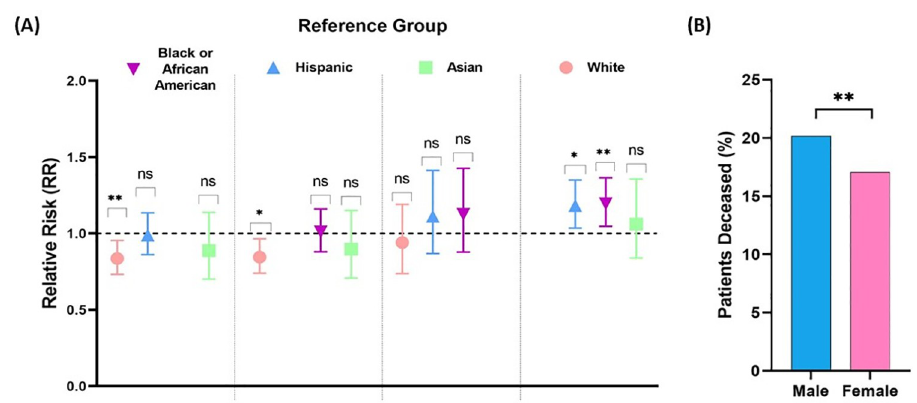
Fig 3. COVID-19 mortality in Mount Sinai Health Systems stratified by race and ethnicity and by sex. (A) Relative risk of mortality from COVID-19 stratified by race and ethnicity. Whites have a higher relative risk of mortality from CoV2 infection relative to the Black or African American and Hispanic population. There was no significant change in the risk of mortality between the White and Asian population. Reciprocally, both the Black or African American and Hispanic populations have a lower relative risk of mortality relative to the White population. The risk of mortality was not significant between Black or African Americans, Hispanic, and Asian populations. Given the limited population size of the representative Native Hawaiian or Pacific Islander and American Indian or Alaskan Native populations, subgroup analysis of the relative risk of mortality could not be assessed. Relative risk (RR) calculations and Fisher’s exact test for significance were performed; �� p < 0.01, � p = < 0.05, ns = not significant. (B) Relative risk of mortality from COVID-19 stratified by sex. Amongst the deceased population, the risk of mortality was 1.188 -fold greater in the male population (p =